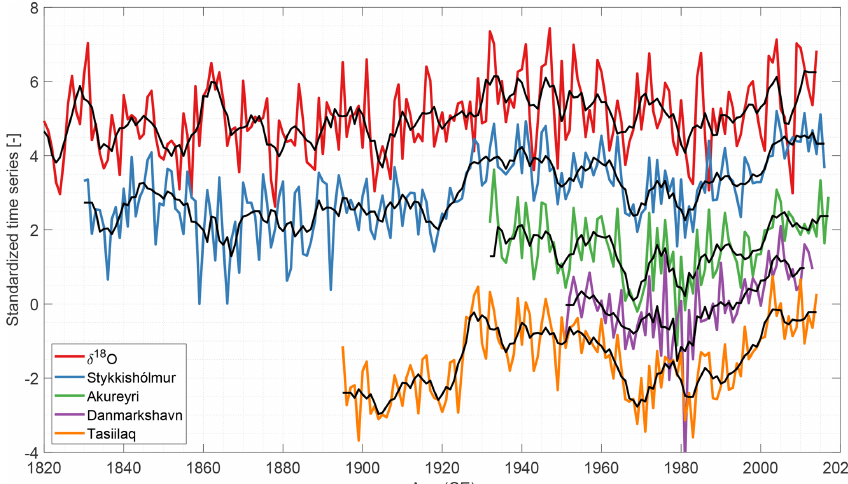
Figure 4. Annually averaged δ 18 O and temperature series. For visualization, the time series have been standardized and shifted vertically. The black curves represent a moving average of 5